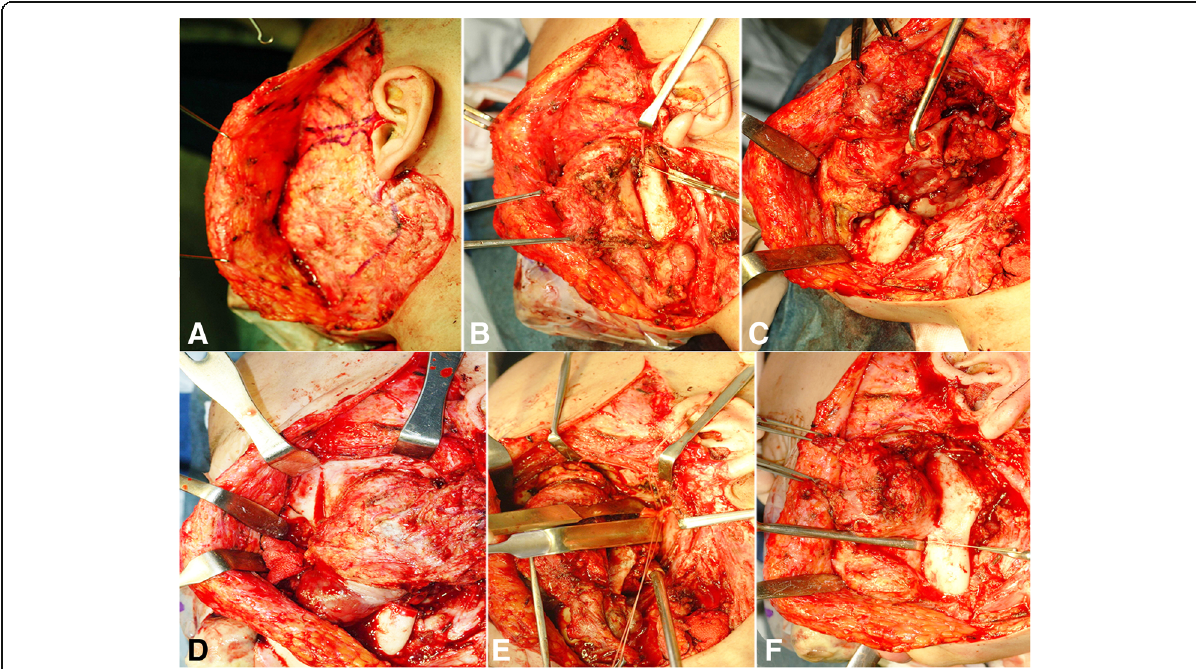
Fig. 3 Surgical procedures of the modified zygomatico-transmandibular approach to the infratemporal fossa, showing the incision with facial flap elevation ( a ), exposure and isolation of the facial nerve with mandibulotomy ( b ), direct exposure of the infratemporal fossa ( c ), mass dissection by orbito-zygomectomy with temporal muscle dissection ( d ), identification of the internal jugular vein, internal maxillary artery, ligation ( e ), and mass resection with temporal craniotomy ( f